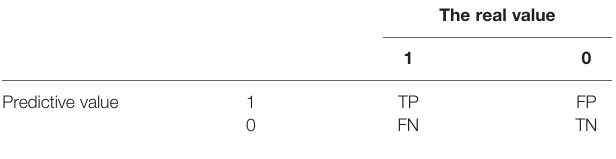
TABLE 2 | Confusion matrix.